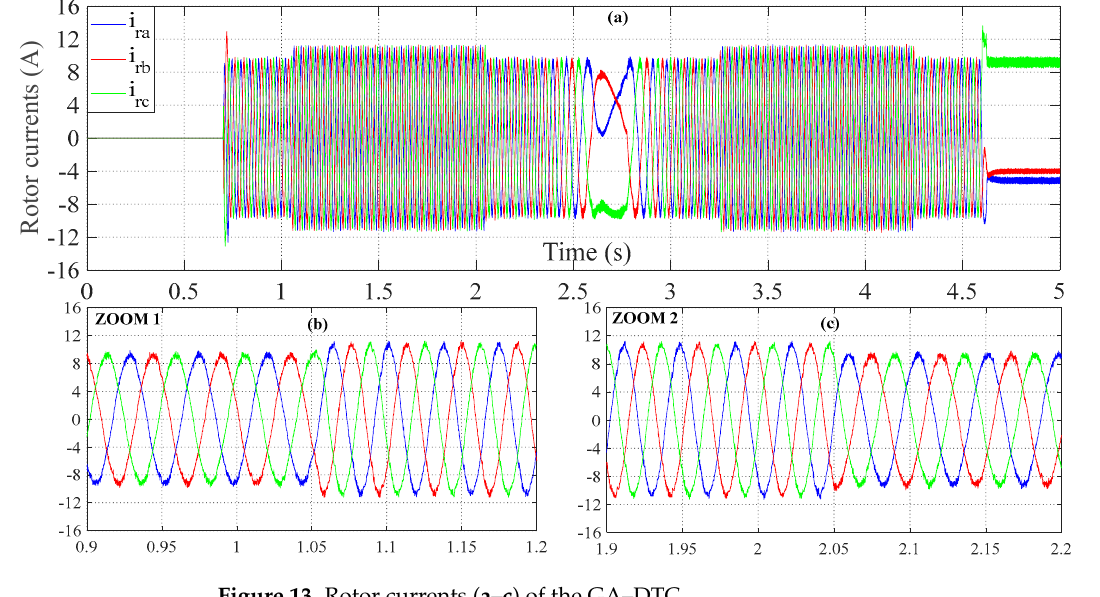
Figure 13. Rotor currents ( a – c ) of the GA–DTC.